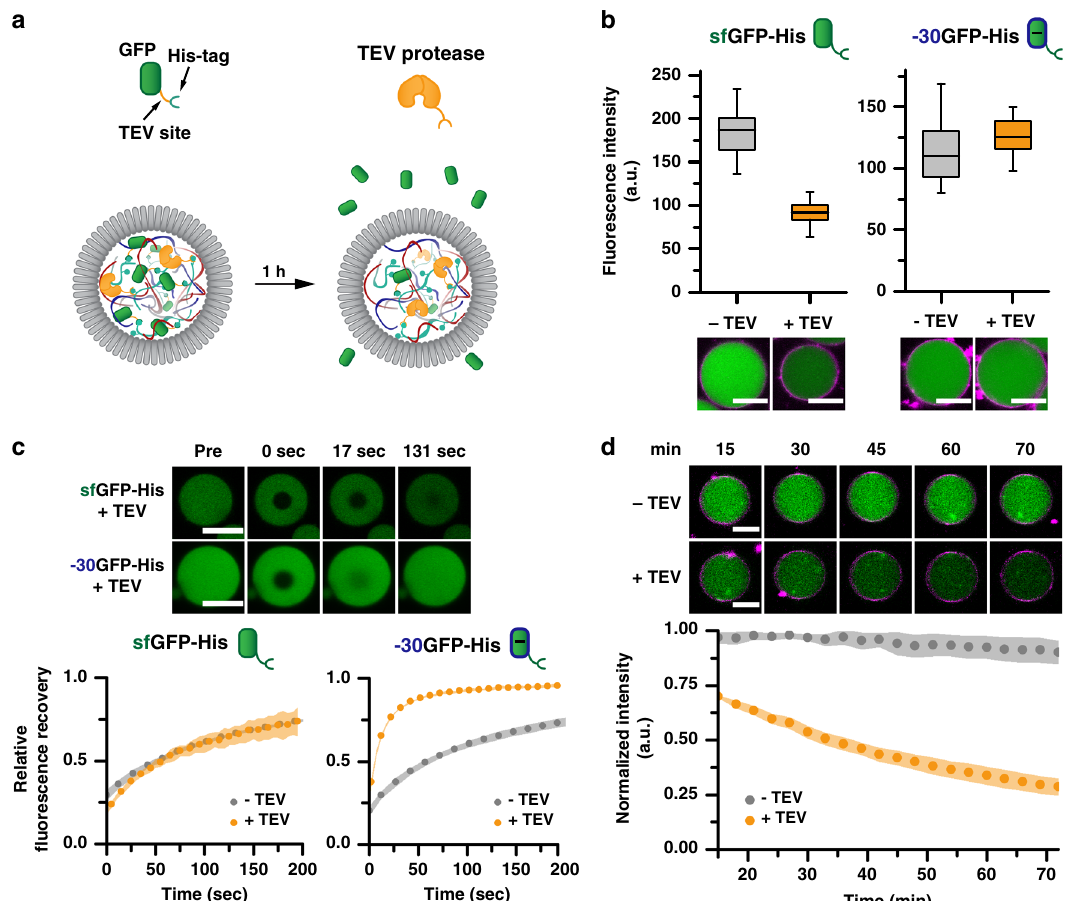
Fig. 5 Protein excretion induced by TEV protease-mediated His-tag removal. a Schematic overview of the GFP construct design and the TEV protease- mediated release. b Box plot analysis of the fl uorescence intensity inside the coacervate droplet incubated with (orange) and without (gray) TEV protease for both 100 nM of sfGFP (left) and − 30GFP (right). n > 30. Membrane stained with Nile red (purple), scale bar: 10 µ m. Uncropped images (Supplementary Fig. 27). c FRAP analysis of both the sfGFP and − 30GFP after 1 h of incubation with TEV protease. Top: confocal images of the FRAP experiment. Scale bar: 10 µ m. Bottom: Fluorescence recovery plotted over time. Left: sfGFP with TEV (orange), sfGFP-His without TEV (gray). Right: sfGFP with TEV (orange), − 30GFP without TEV (gray). The standard deviation of three individual measurements is represented by the shaded area. Data fi ts available in Supplementary Fig. 29. d Release pro fi le of 250nM sfGFP determined by confocal microscopy. Top: Time series of representative protocells. Membrane stained with Nile Red (purple), scale bar: 10 µ m. Uncropped images (Supplementary Fig. 30) Bottom: Normalized fl uorescence intensity of n = 20 protocells extracted from confocal time series. The standard deviation is represented by the shaded